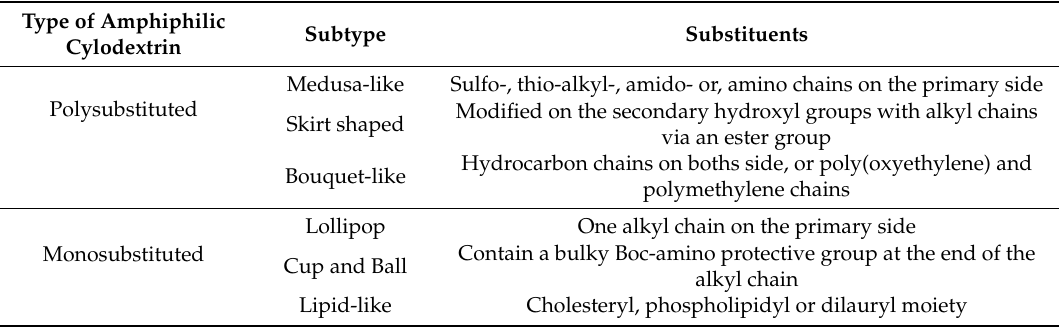
Table 2. Types of amphiphilic cyclodextrins with